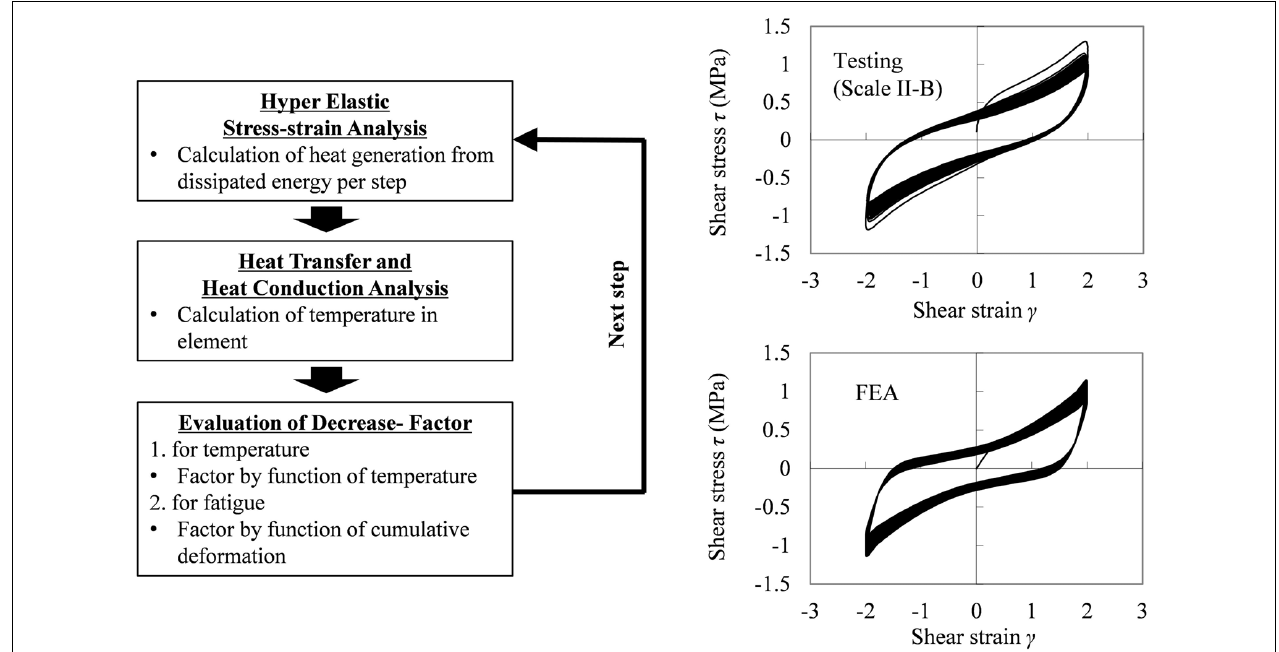
FIGURE 12 | Concept of heat-mechanics coupled FEA and comparison of shear stress-strain relationship of Testing (Scale II-B) and FEA results.